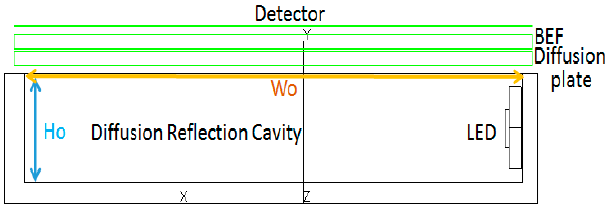
Figure 3. Hollow light guide module for planar light source, where BEF is brightness enhancement film. Table 2. E ffi ciency and uniformity of a light module at various aspect ratio values. W